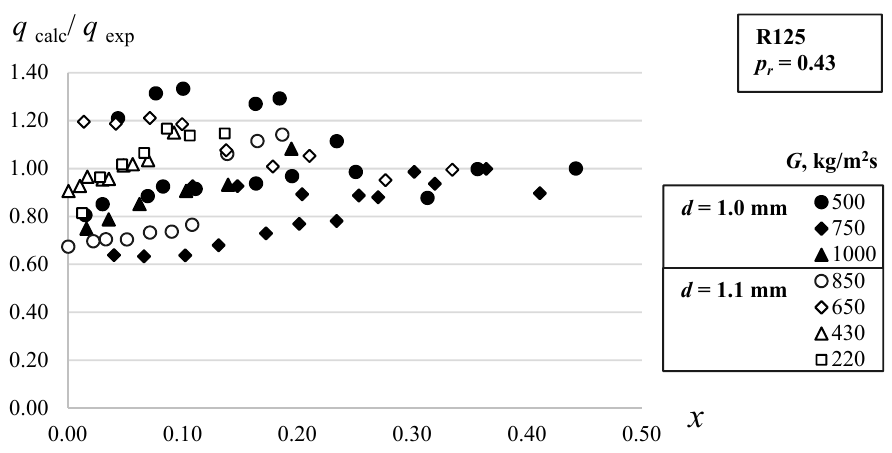
Figure 12. Comparison of the experimental data with the calculated data obtained using Formulas (16)–(19).